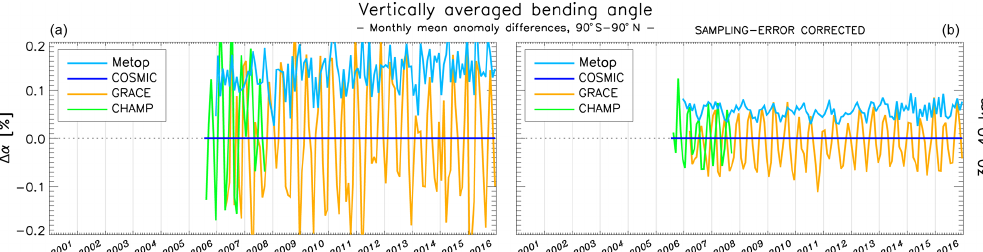
Figure 13. Differences between monthly mean CHAMP, GRACE, and Metop refractivity anomalies relative to COSMIC, globally averaged in the 30–40km altitude layer (a) without sampling-error correction and (b) with sampling-error correction